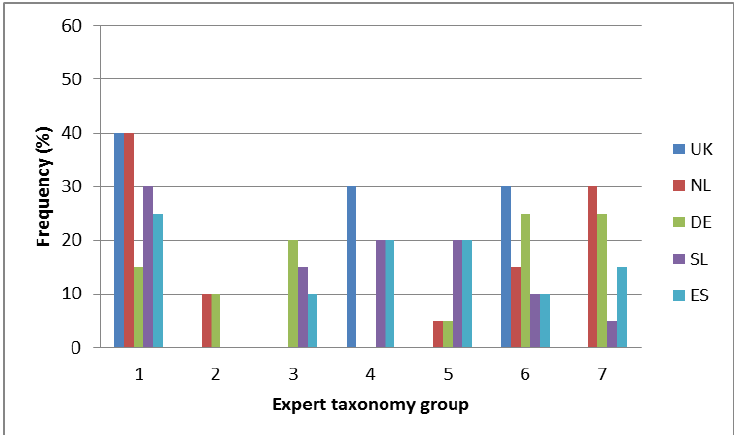
Figure A7. Frequency of structured sort placement of nutrition claims per country—‘One of your 5 a day’ (Card 25).